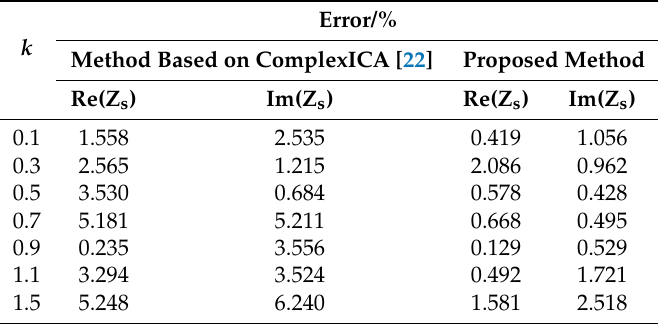
Table 2. Errors of two methods for different k .